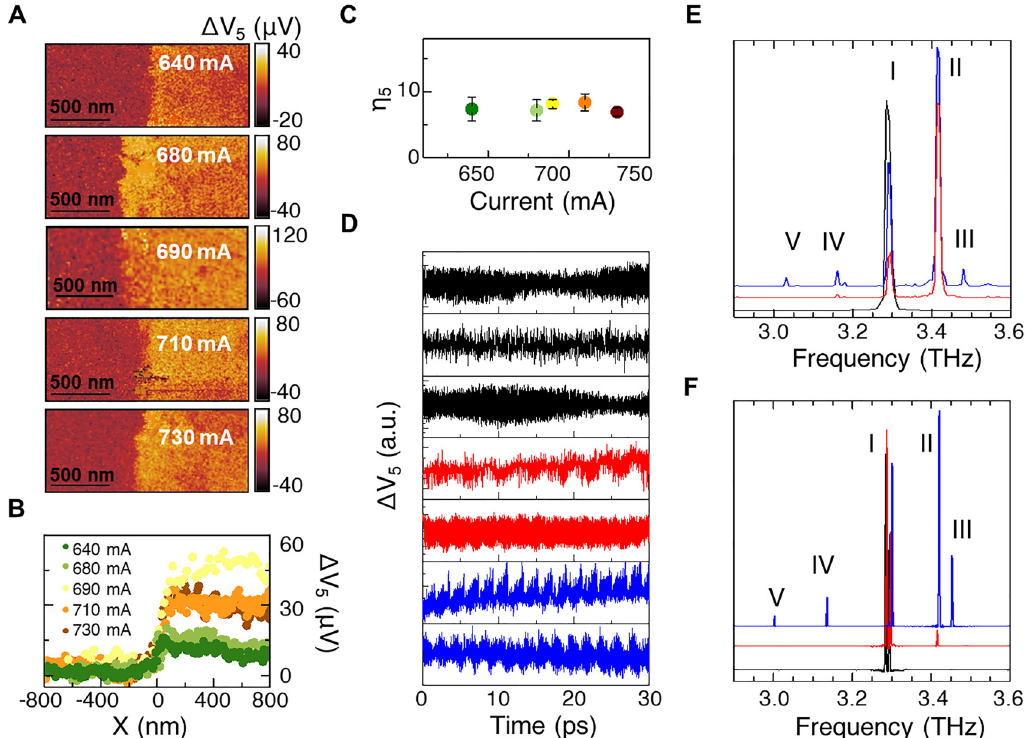
Figure 5: Near-field self-mixing measurements at various applied current. (A) Self-mixing signal Δ V 5 demodulatedat the fi fthharmonicsof thetappingfrequency ω t ,collectedwhilevaryingthedrivinglasercurrent.(B) Line pro fi le of the Δ V 5 signal along the Au-substrate interface, extracted from the maps of panel (A), by averaging vertically for 40 nm and corresponding to different driving currents ranging from 640 to 730 mA. (C) Signal contrast η 5 evaluated as the ratio between the average Δ V 5 signalsfromAuandfromthesubstrate,determinedfromthelinepro fi lesinpanel(B),showingconstantvaluewiththedrivingcurrent.(D)Time evolutionoftheself-mixingtracescollectedwithafastlock-inampli fi er(Zurichinstruments,UHFLILock-inampli fi er),whilevaryingthelaserto tip distance L ext ( L in Eq. (1)) and while driving the QCL with different currents: (from top to bottom) I = 640 mA; I = 660 mA; I = 680 mA; I = 690 mA; I = 700 mA; I = 710 mA; I = 730 mA. The resolution is given by the minimum displacement, that is 100 nm, which corresponds to a minimumtimedelay(i.e.,temporalresolution) ofabout 0.3fs.(E)EmissionspectraretrievedwhileFouriertransformingtheself-mixingtraces ofpanel(D)collectedat I =640mA, I =690mAand I =730mA(frombottomtotop).(F)FTIRmeasurementsinthefar- fi eldwhichagreewellwith the near- fi eld spectra obtained from the SM fringes (from bottom to